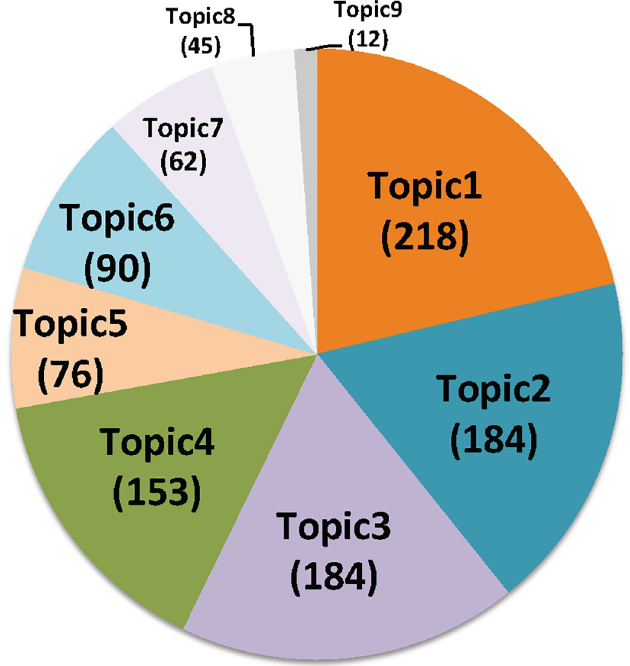
Fig 2. LDA topic categorization of CHO bibliome: Distribution of bioprocessing documents in each of the 9 topics discovered by LDA model.